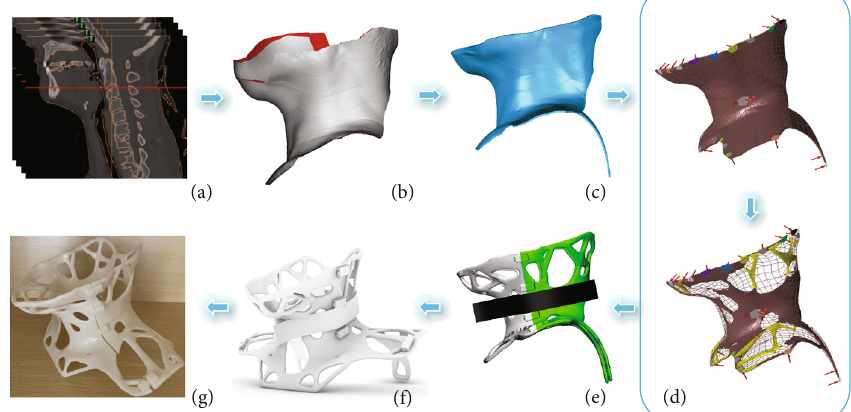
Figure 1: Schematic representation of design work fl ow and fabrication process of a custom orthosis. (a) Spiral CT scan. (b) 3D reconstruction of cervical skin. (c) This geometry is fi tted. (d) Topology optimization of geometry. (e) Adjust the model structure and add a fi xed buckle structure. (f) Schematic diagram of the CAD model. (g) This orthosis is obtained by 3D